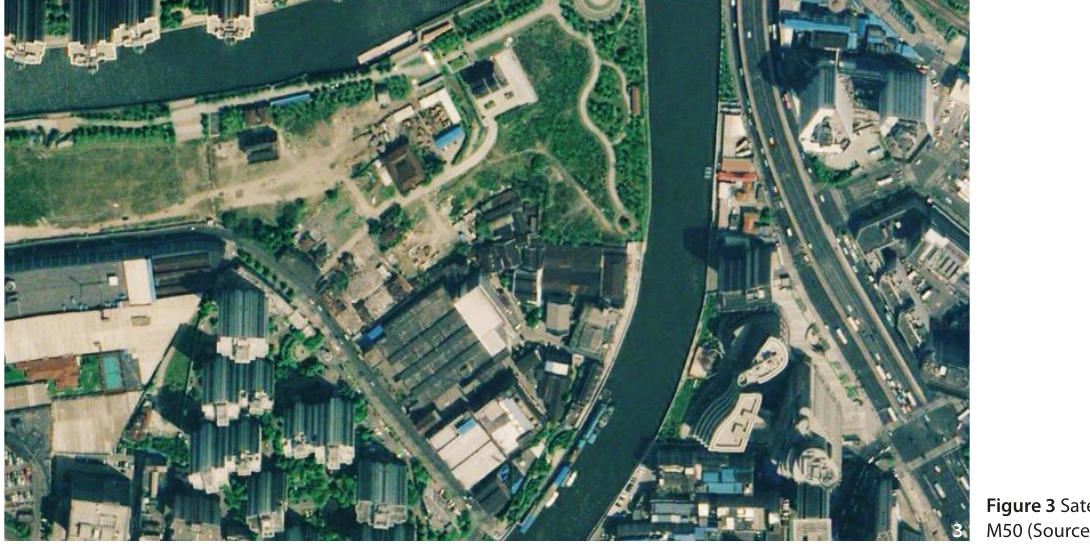
Figure 3 Satellite image of M50 (Source: Baidu Map).